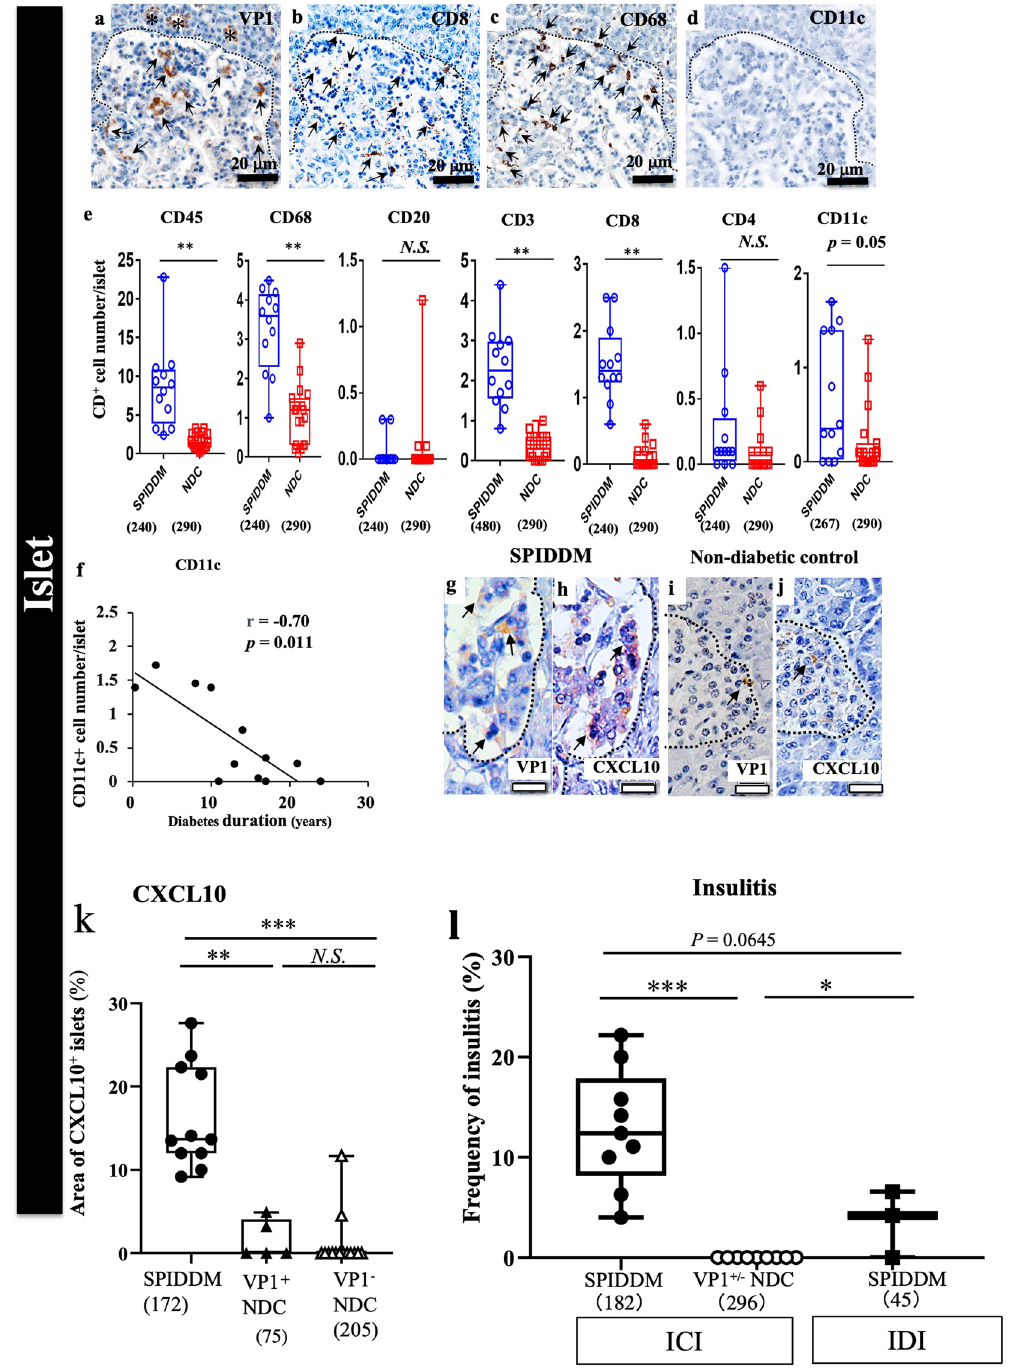
Figure 6. Characteristic features of EV infection and islet inflammation in SPIDDM. (a–c) Serial sections of islet stained for VP1 ( a ), CD8 ( b ), CD68 ( c ), and CD11c ( d ) in SPIDDM islets (Case SP2). The VP1-positive islet ( a ) is infiltrated by CD8 + T cells ( b ) and CD68 + macrophages ( c ). Scale bar: 20 μm. ( d ) Note that CD11c DC is not observed in the islet. ( e ) Numbers of CD45 + , CD8 + , and CD68 + cells, not CD20 + , CD4 + , and CD11c + cells, in islets are significantly higher in SPIDDM than in non-diabetic controls (NDCs). Numbers in parentheses indicate counted islets. ** P < 0.01, Tukey’s test. ( f ) Number of CD11c + DCs in islets decreases significantly with duration of SPIDDM. P < 0.01, Pearson’s correlation coefficient. ( g–j ) Consecutive sections stained for VP1 ( g,i ) and CXCL10 ( h,j ) in islets of SPIDDM and non-DC pancreases. VP1 (brown, arrows) is present in SPIDDM islet cells ( g ). ( h ) VP1-positive islet cells express CXCL10 in a high proportion of the SPIDDM pancreas. ( i,j ) In only 2 of 19 non-DC cases, both VP1 and CXCL10 are positive in islets ( i ) and CXCL10 ( j ). ( k ) CXCL10-positive area is significantly higher in islets in SPIDDM than in non-DCs. Numbers in parentheses indicate number of counted islets. ** P < 0.001, Performed by Tukey’s test. ( l ) T-cell insulitis was observed in all cases of SPIDDM, whereas no T-cell insulitis was observed in VP1-positive or VP1-negative non-DCs ( l ). The frequencies of T-cell insulitis in insulin-containing islets (ICIs) and islets deficient beta cells (insulin-deficient islets: IDIs) in SPIDDM were insignificant. Performed by Tukey’s